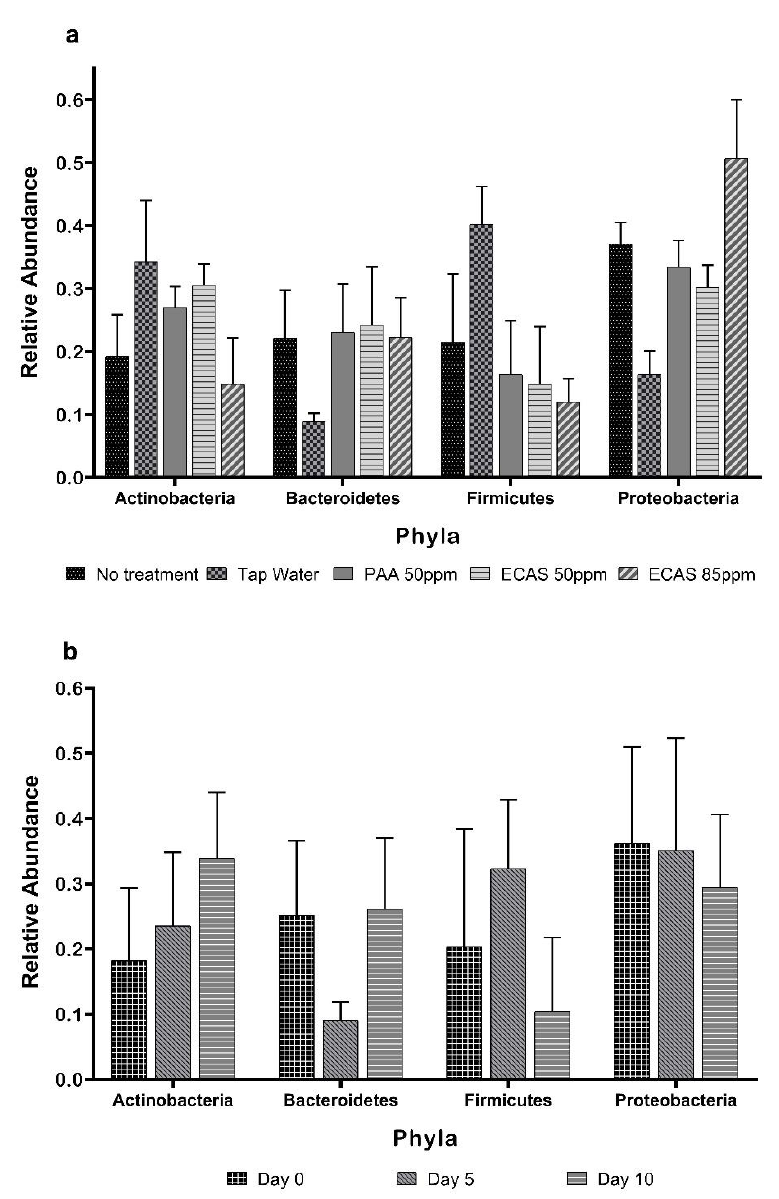
Figure 1. Relative abundance of phyla (Proteobacteria, Bacteroidetes, Firmicutes, Actinobacteria) for samples collected ( a ) after the sanitizing wash (no wash, tap water, peroxyacetic acid (PAA) at 50 mg / L, ECAS at 50 mg / L and 85 mg / L of free available chlorine (FAC)), and ( b ) immediately after the treatment (day 0) and on days 5 and 10 post sanitizing wash.